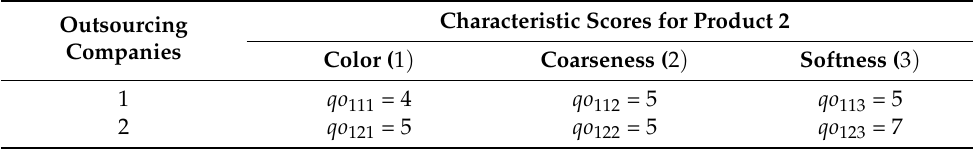
Table 4. Characteristic scores for semi-products from outsourcing companies.